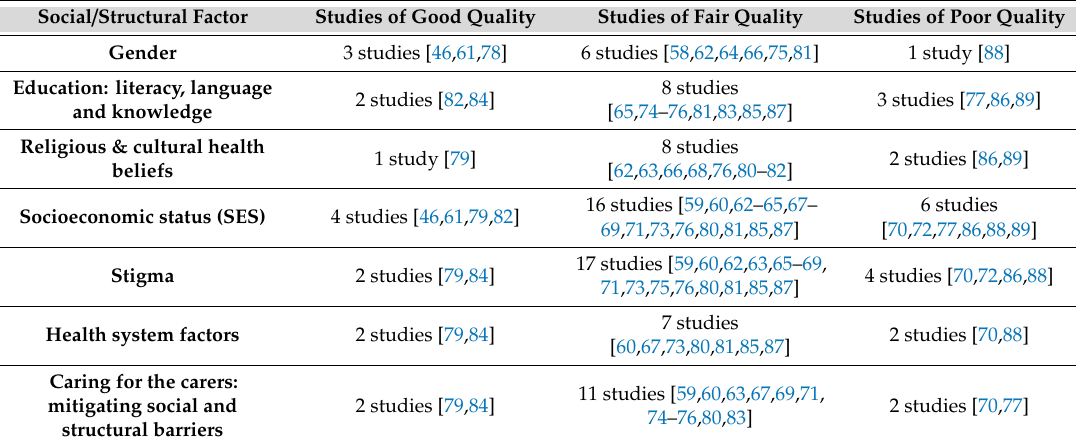
Table 2. Assessed quality of studies categorised by each social / structural factor drawn from the review (and those referencing